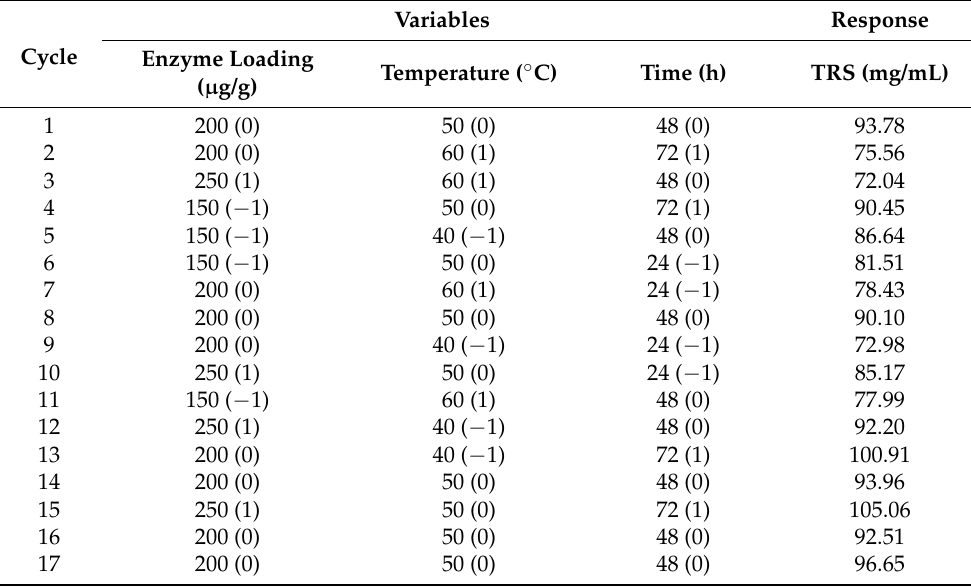
Table 3. Box–Behnken experimental data and corresponding TRS values for various combinations of three independent variables in the enzymatic hydrolysis